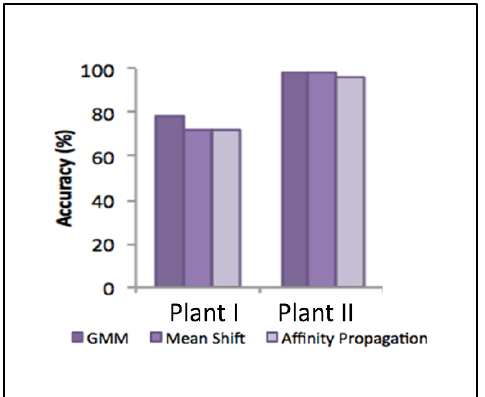
Figure 5. A comparison among the accuracy results of GMM, Mean Shift and Affinity Propagation using K-Means as the initial labeling method.